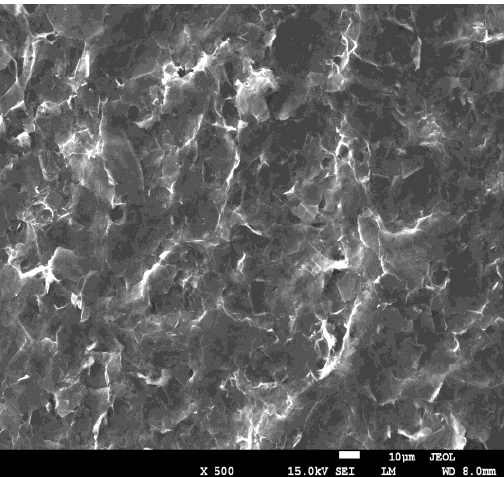
Figure 2. The dependence of the films’ absorbance at λ max = 232 nm on the number of (GO + /GO − ) deposition cycles formed at quartz surfaces.